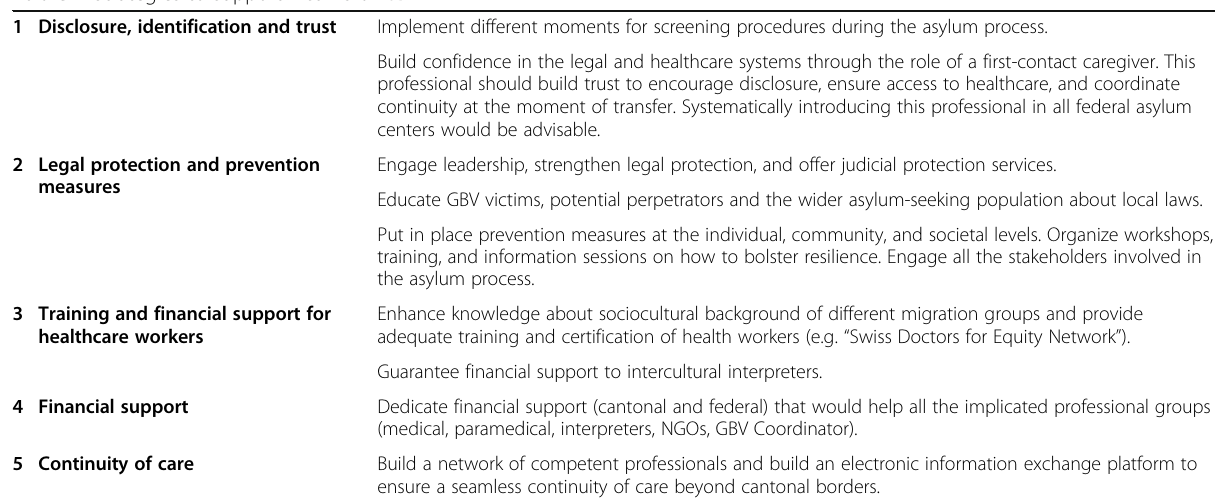
Table 2 Strategies to support victims of